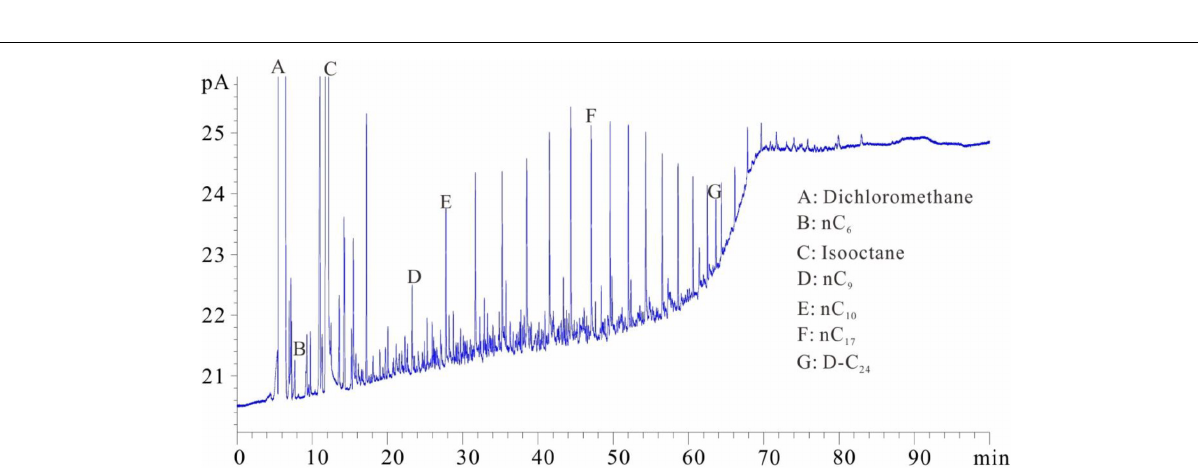
Frontiers in Earth Science |